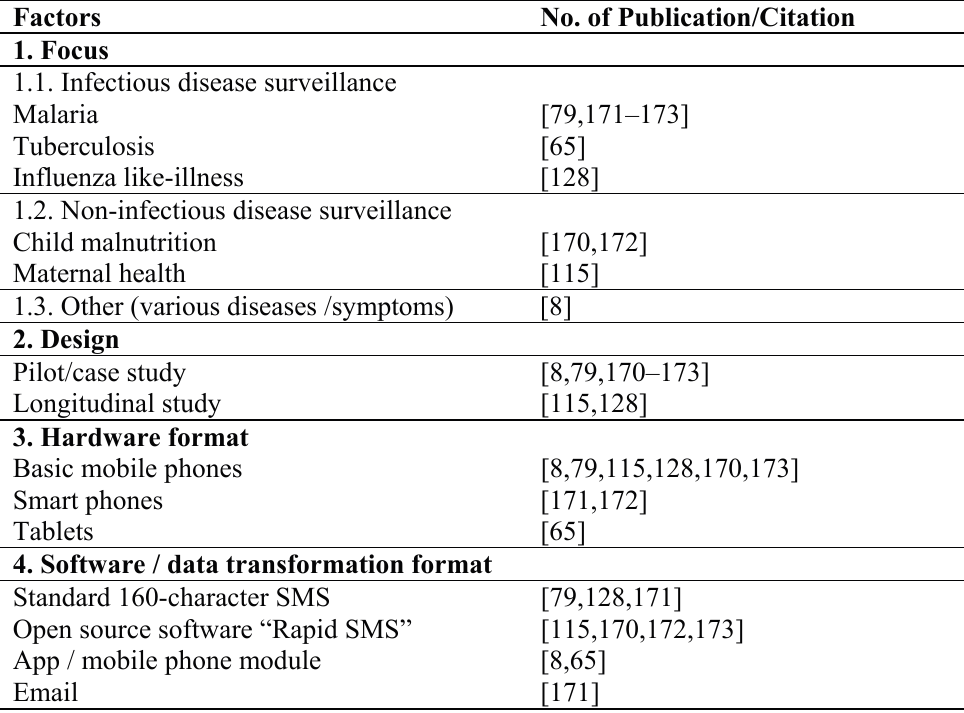
Table 3. Methodological characteristics of included